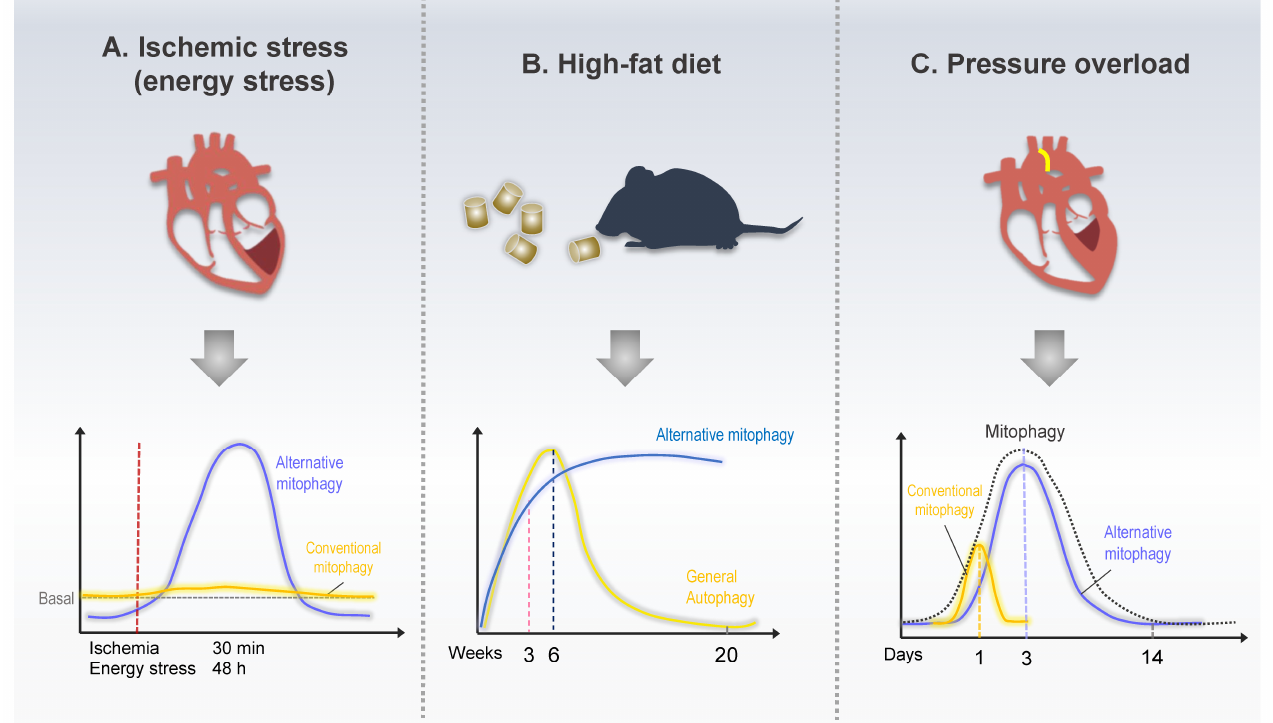
Figure 4. Schematic model of mitophagy in response to heart disease. ( A ) Mice exhibited increased alternative mitophagy levels 30 min after ischemia or 48 h after starvation, whereas conventional mitophagy did not change in response to energy stress. ( B ) Mice fed a high-fat diet (HFD) exhibited increased conventional mitophagy up to 6 w after the beginning of HFD feeding. The level of alternative mitophagy kept increasing even after 24 weeks of HFD feeding. C . During pressure overload, conventional mitophagy was acutely activated within a day of TAC, whereas alternative mitophagy exhibited prolonged activation between 3 and 7 days after TAC.